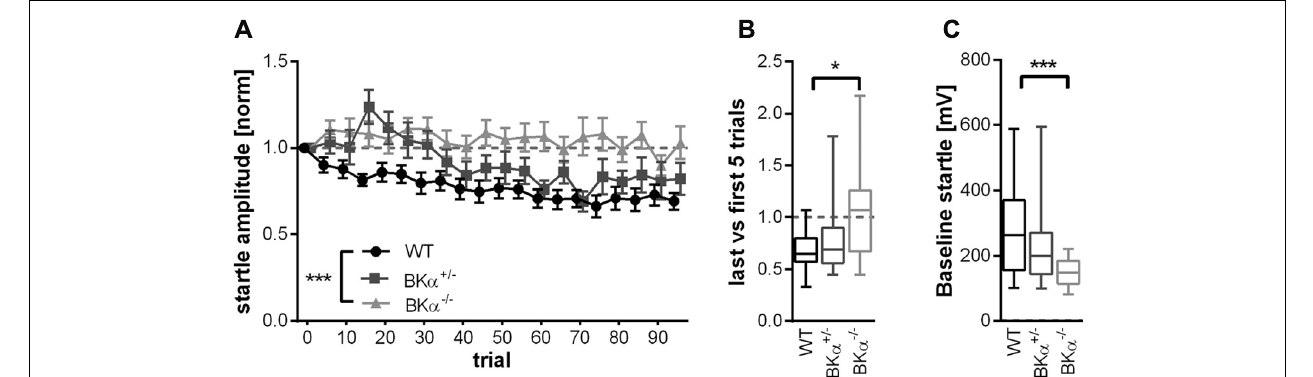
FIGURE 3 | Short-term habituation of the acoustic startle reflex. (A) Of the 100 normalized startle response amplitudes of BK α − / − , BK α + / − , and WT mice, five consecutive startle responses were always averaged to one block. WT mice show a decline in response amplitude, whereas knock-out animals show no decline, with heterozygous animals intermediate. Error bars indicate standard error. *** p = 0.001. In (B) the habituation scores of the respective genotypes are displayed (first five versus last five responses,